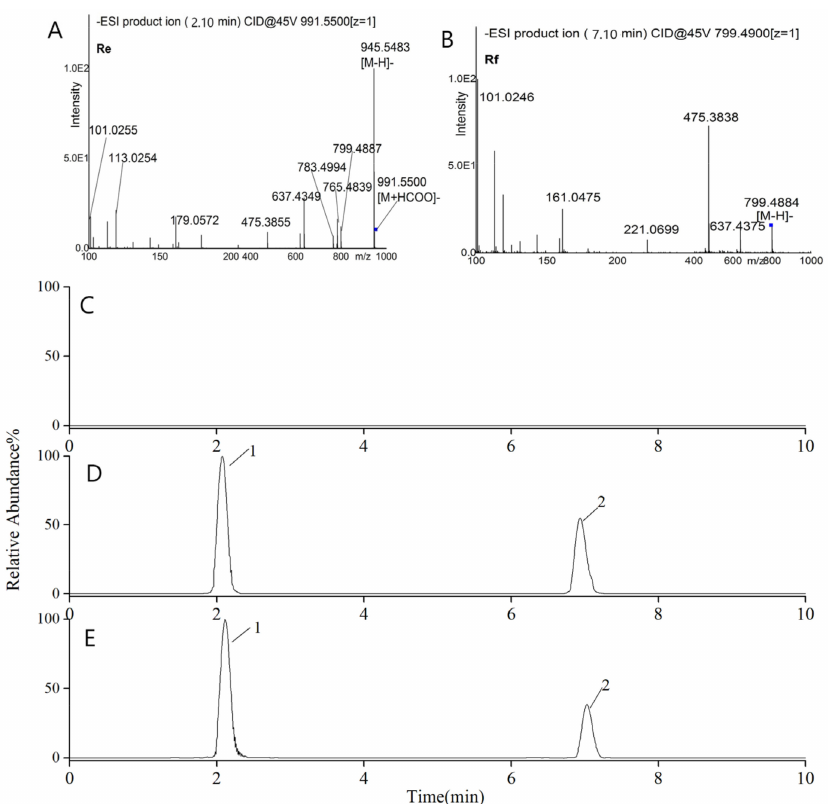
Figure 9. Tandem Mass spectra of G-Re ( A ), IS ( B ), and LC-MS/MS chromatograms of blank plasma ( C ), plasma spiked with G-Re and IS ( D ), and plasma sample after oral administration ( E ) respec- tively. Peak “1” represented G-Re, “2” represented IS. G-Re was detected at m/z 945.5 → 637.3 and 637.3 → 475.3 using MRM.